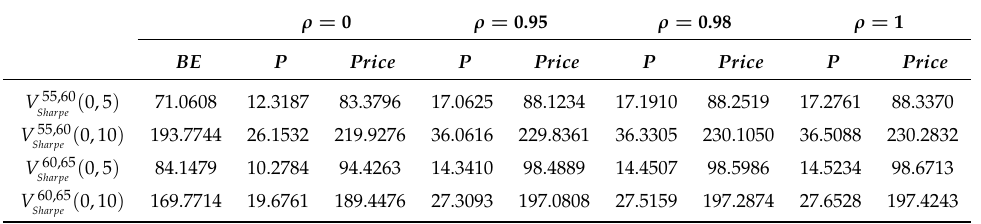
Table 7. The prices of the different GS-forwards for different ages, maturities, and correlations, Sharpe method. ρ = 0 ρ = 0.95 ρ = 0.98 ρ =